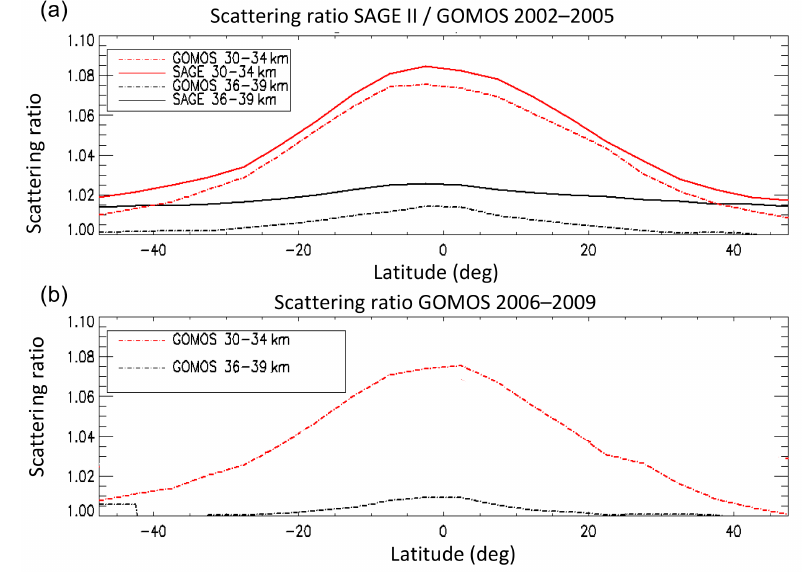
Figure 2. Scattering ratio at 30–34 and 36–39km at 532nm (a) from SAGE II and GOMOS for the years 2002–2005 and (b) from GOMOS for the years